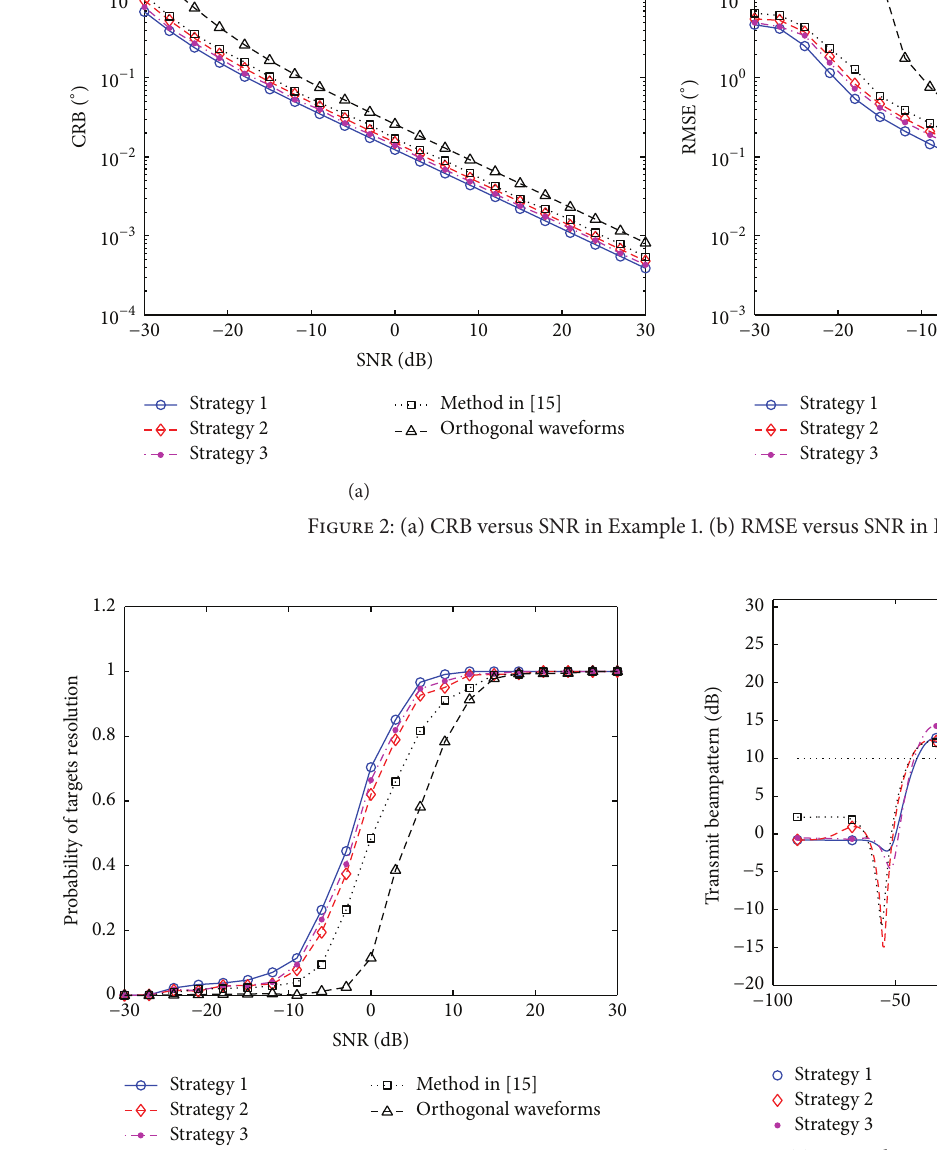
Figure 3: Probability of target resolution versus SNR in Example 1.